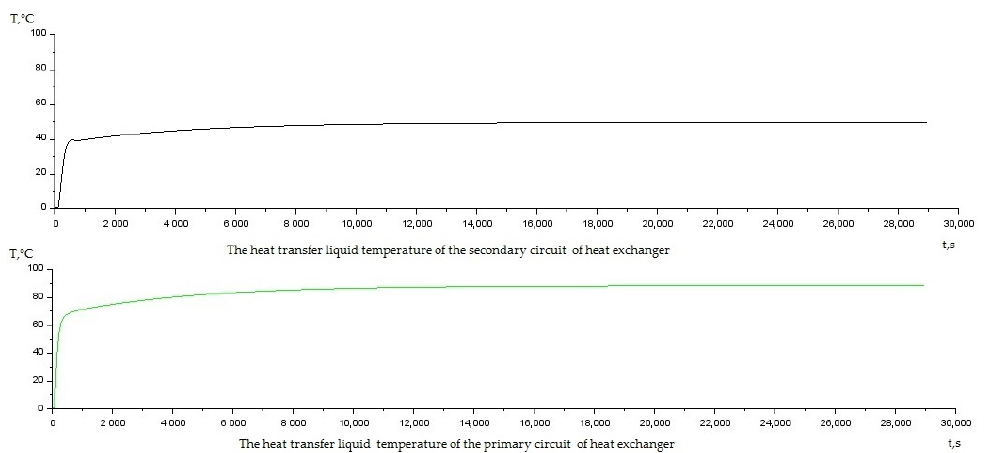
Figure 9. Transient characteristics of the model of the automatic control system of the temperature of the heat carrier with an acoustic–magnetic device.